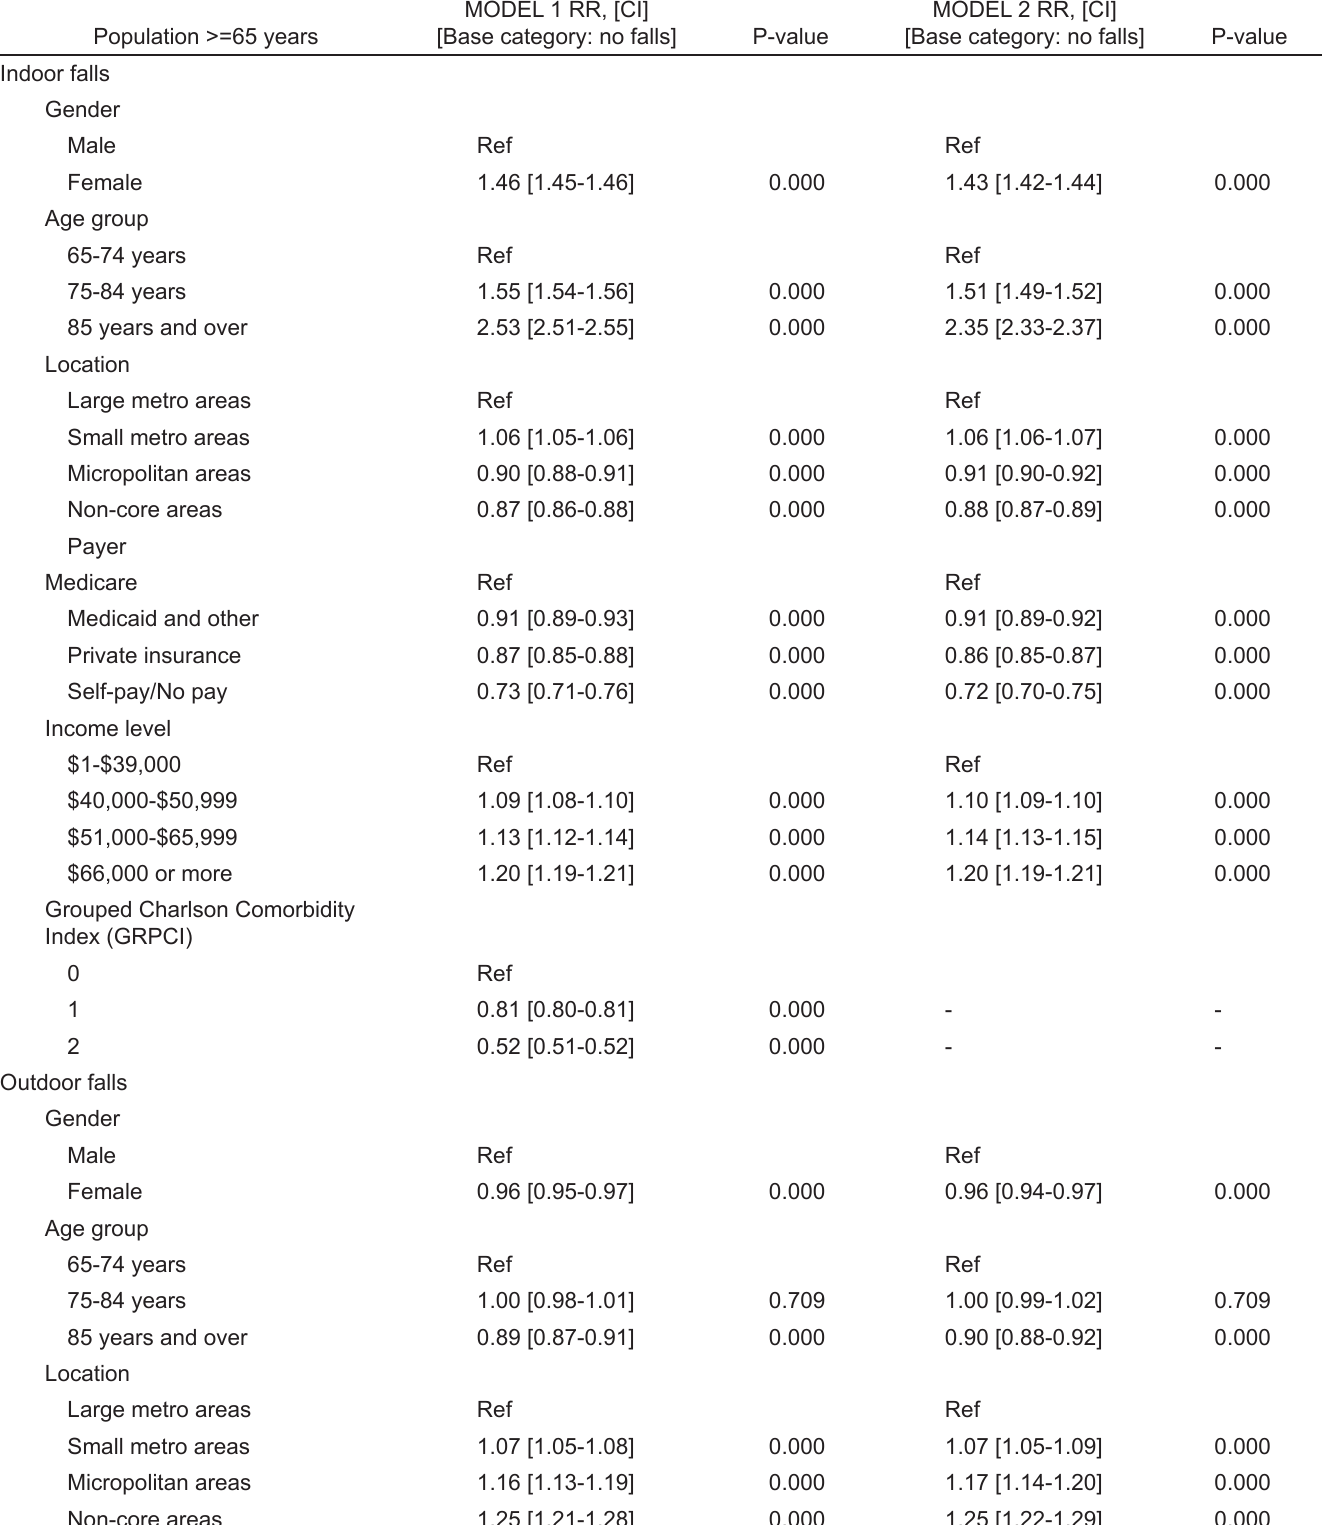
Table 3. Multivariable multinomial logistic regression analysis (N = 27,522,770 (weighted)): Predictors of indoor falls (0 = no falls; 1